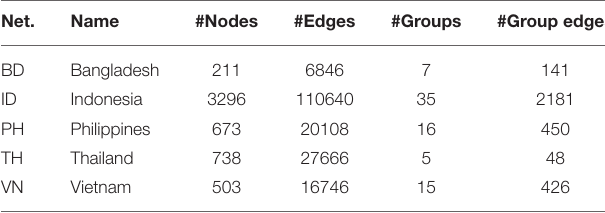
TABLE 2 | List of real-world networks used and their attributes. Net.